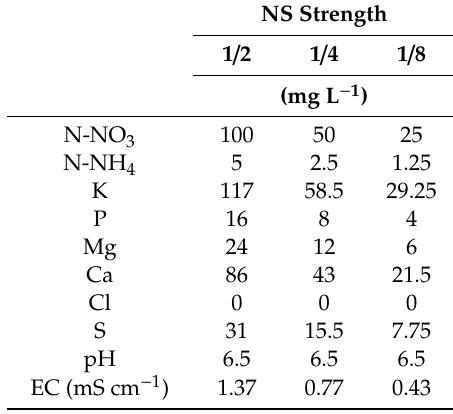
Table 1. Characteristics of the nutrient solutions (NS) used during the first